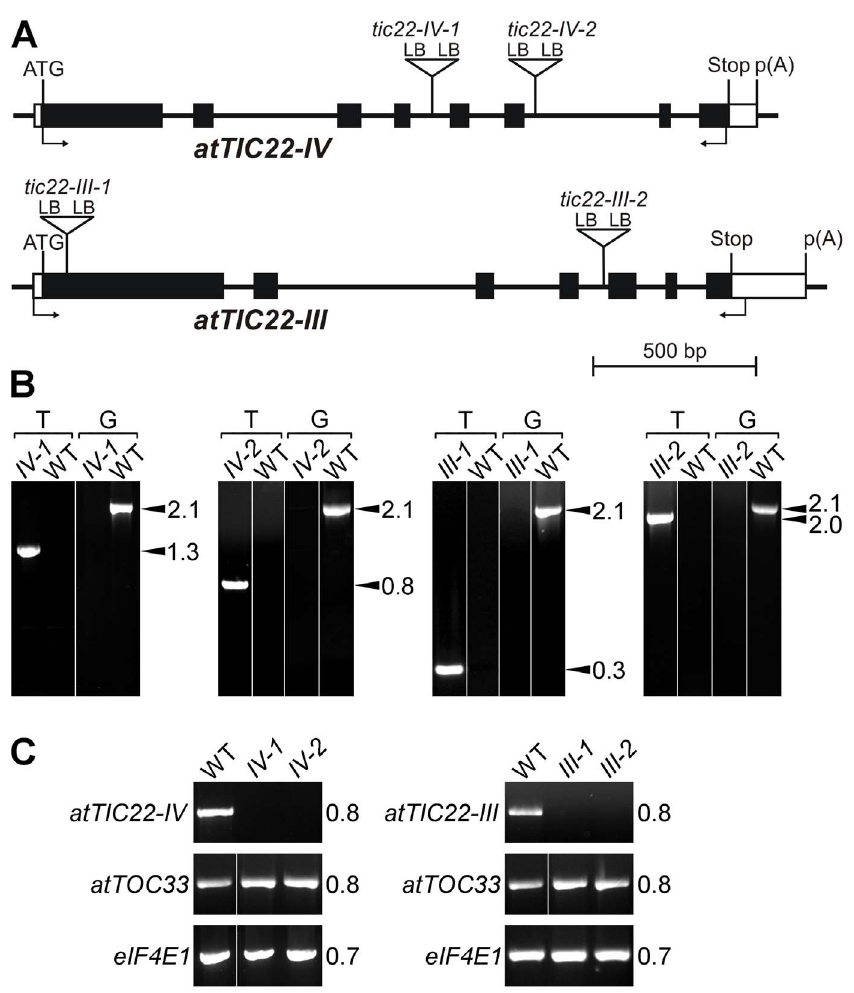
Figure 3. Molecular characterization of the Tic22 T-DNA insertion lines. A. Diagrams showing the structure of each gene and the locations of T-DNA insertions. Protein-coding exons are represented by black boxes, untranslated regions by white boxes, and introns by thin lines between the boxes. Locations of RT-PCR primers are shown by arrows beneath each gene model. T-DNA insertion sites are indicated precisely, but insertion sizes are not to scale. ATG, translation initiation codon; Stop, translation termination codon; p(A), polyadenylation site; LB, T-DNA left border. B. Genomic DNA samples extracted from wild type and putative homozygous mutants were analysed by PCR. Appropriate T-DNA- and atTIC22 -gene- specific primers were employed. Two different primer combinations were used in each case: the first (‘‘T’’) comprised one T-DNA border primer and one gene-specific primer (LB + reverse: tic22-1V-1 , tic22-IV-2 , tic22-III-2 ; LB + forward, tic22-III-1 ); the second (‘‘G’’) comprised two gene-specific primers flanking the T-DNA insertion site. The PCR products were resolved by agarose gel electrophoresis, and visualized by staining with SYBR Safe. Amplification using ‘‘T’’ indicated the presence of the mutant allele, whereas amplification using ‘‘G’’ indicated the presence of the wild-type allele; amplification with the former but not the latter demonstrated that the plant was homozygous mutant. The genotype names are shortened as follows: ‘‘ 22-IV-1 0 indicates tic22-IV-1 ; ‘‘ 22-IV-2 0 indicates tic22-IV-2 ; and so on. Sizes of the amplicons are indicated at right (in kb). C. Expression of Tic22 genes in wild-type and mutant plants was analysed by RT-PCR. Locations of the amplification primers are shown in A. Similar analysis of atTOC33 and of the translation initiation factor gene eIF4E1 (At4g18040) was used to normalize loading. Amplicon sizes are indicated at right (in kb). RNA samples were from whole, 10-day-old homozygous plants grown in vitro , and were representative of , 20–30 seedlings. PCR amplifications were performed over 25 cycles.